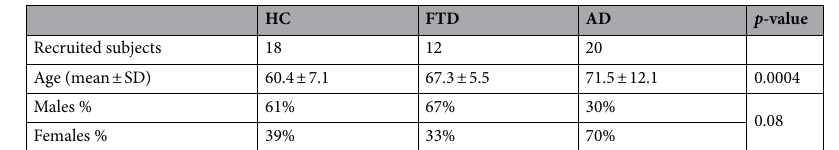
Table 1. Baseline characteristics of recruited subjects for this study. HC = healthy controls; FTD = Frontotemporal Dementia; AD = Alzheimer’s Disease.